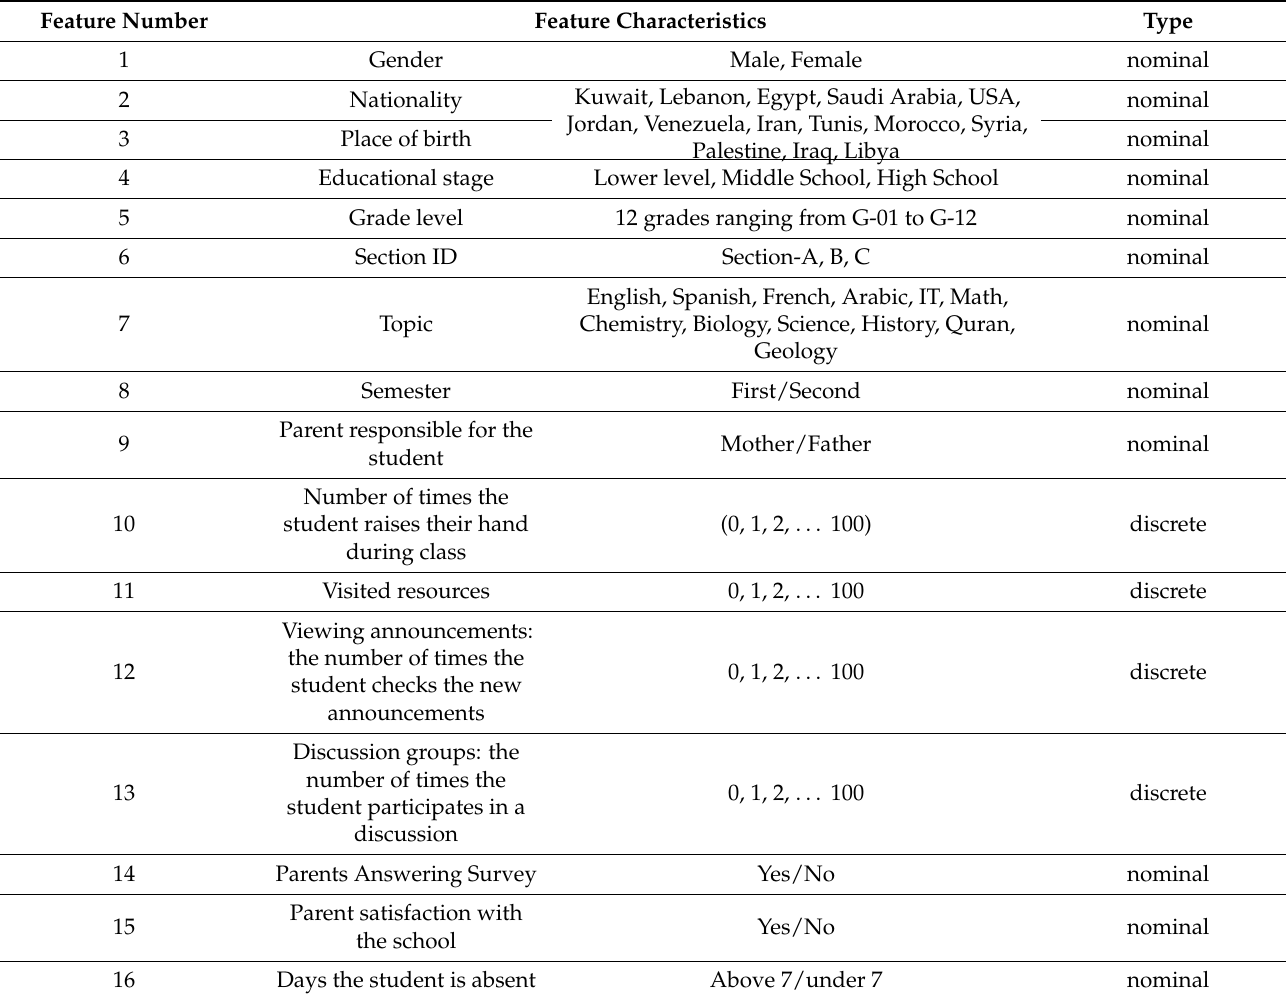
Table 1. xAPI students learning analytics data